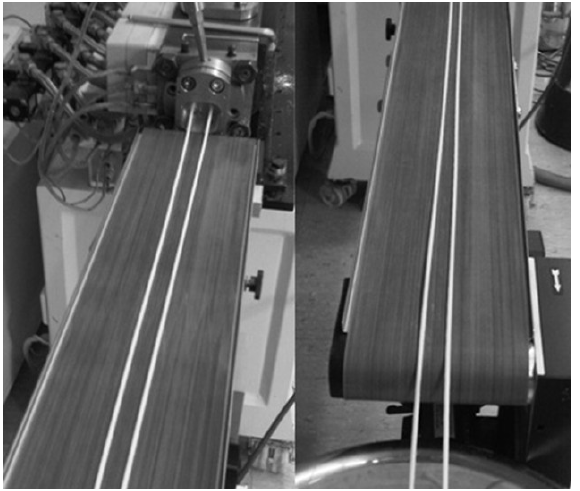
Figure 5. Cylindrical melt-extrudates (diameter 3 mm) based on Poloxamer 188